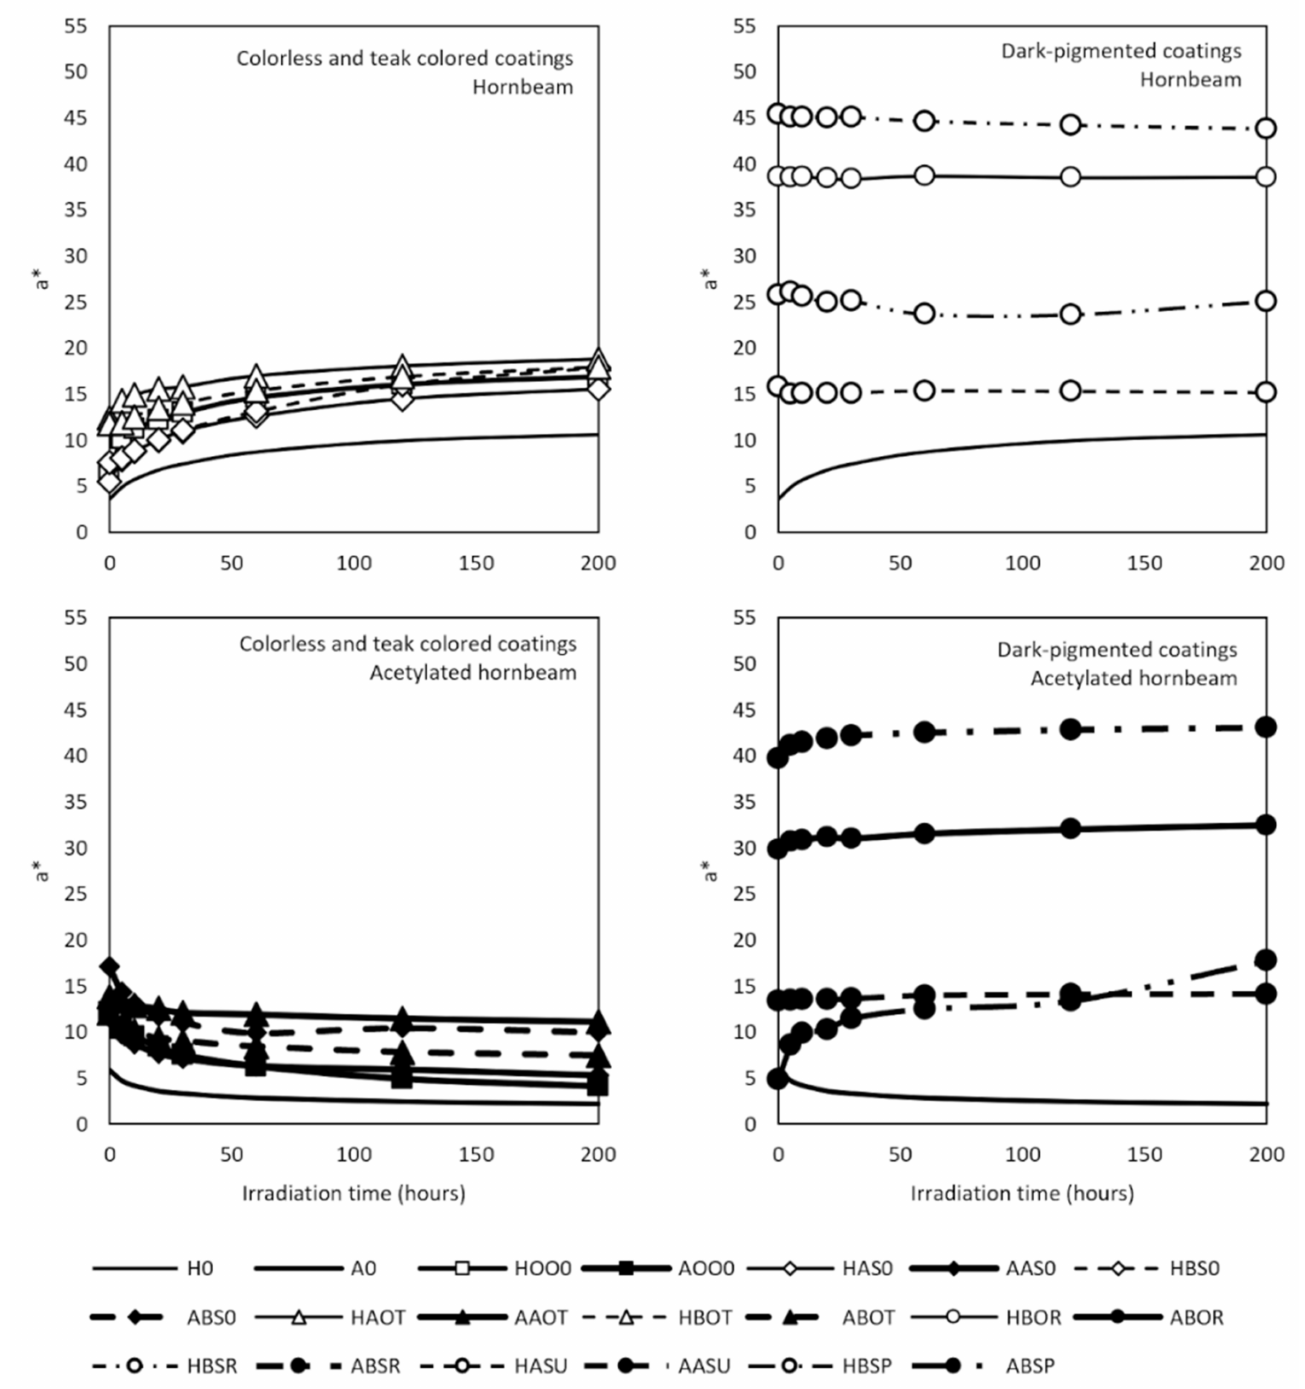
Figure 4. Change of red hue (a*) during 200 h of xenon lamp irradiation. In the case of uncoated, colorless coated (oils and stains), and teak colored samples, hornbeam b* increased as its a* increased, while acetylated hornbeam b* decreased as its a* decreased. On the other hand, dark, pigmented coatings (red, umbra, and palisander) had similar results in hornbeam and acetylated hornbeam: a* and b* decreased or did not change